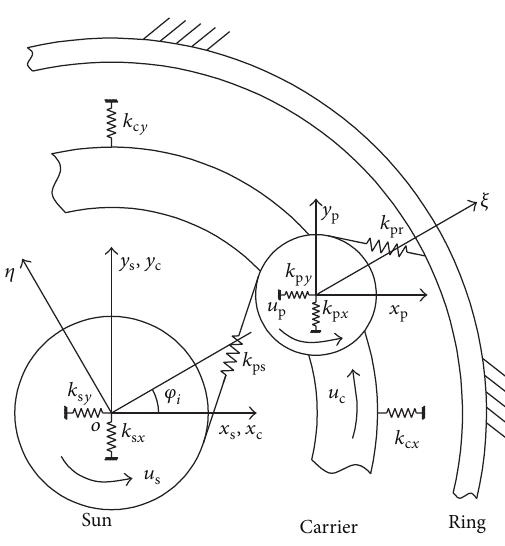
Figure 3: Dynamic model of planetary gear system.